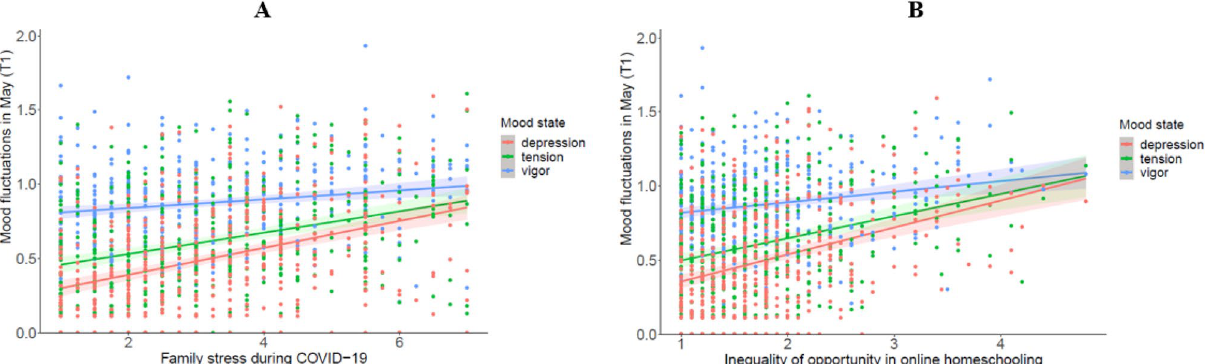
Figure 2. Graph A illustrates the positive associations between family stress and tension and depression fluctuations among adolescents in May 2020 (T1) (N = 462). Graph B illustrates the positive association between the inequality of opportunities in online home schooling and depression fluctuations among adolescents at